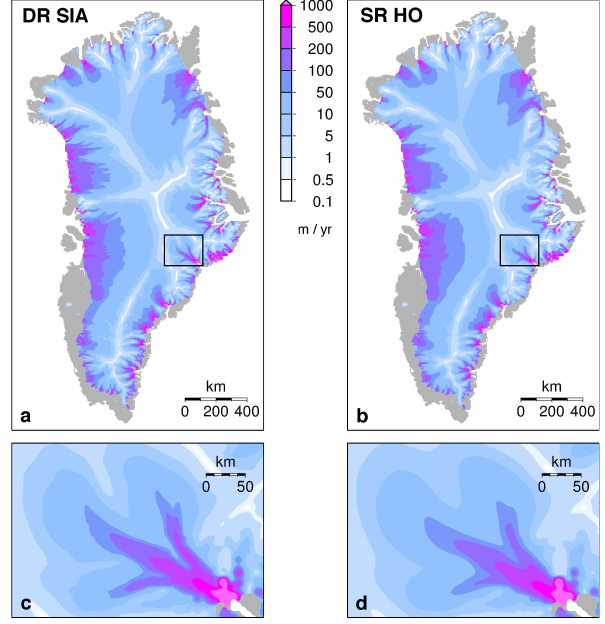
Fig. 1. Surface velocity magnitude for the IS standard interglacial equilibrium with continental outline in grey. The underlying geome- try is obtained with the DR SIA model. (a) and (c) show the velocity magnitude for DR SIA while their higher-order equivalent from SR HO is presented in (b) and (d) for the same geometry. The lower two panels (c) and (d) show a close-up around